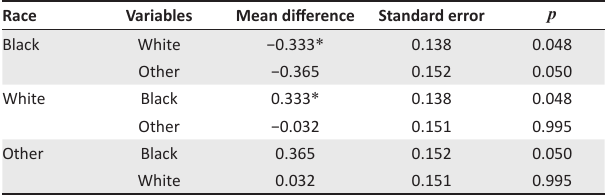
TABLE 11: Results of the post hoc comparison test based on Gabriel’s procedure.